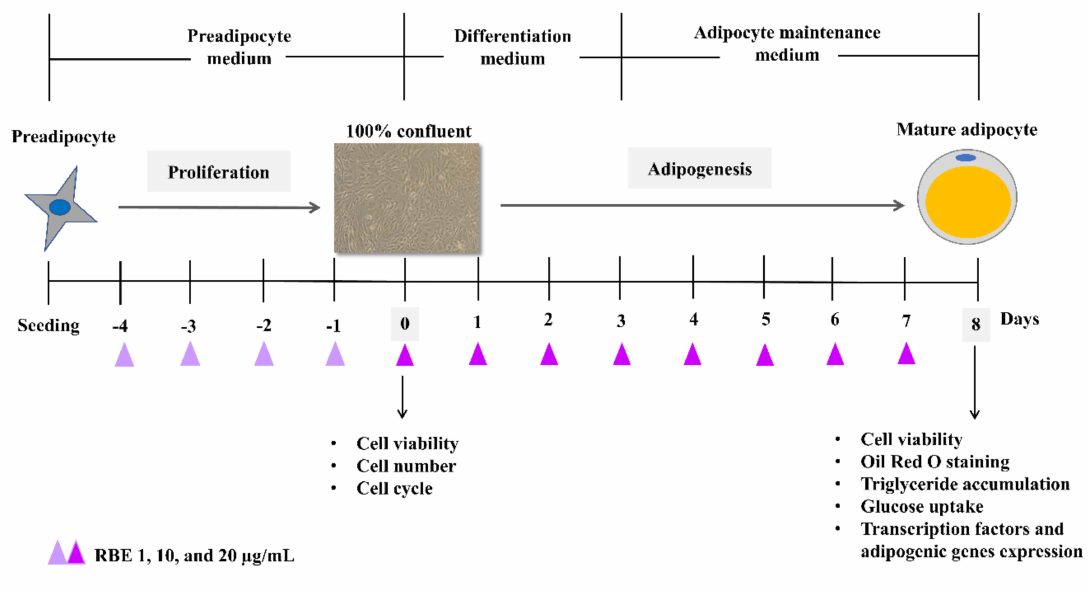
Figure 1. Schematic representation of 3T3-L1 di ff erentiation into